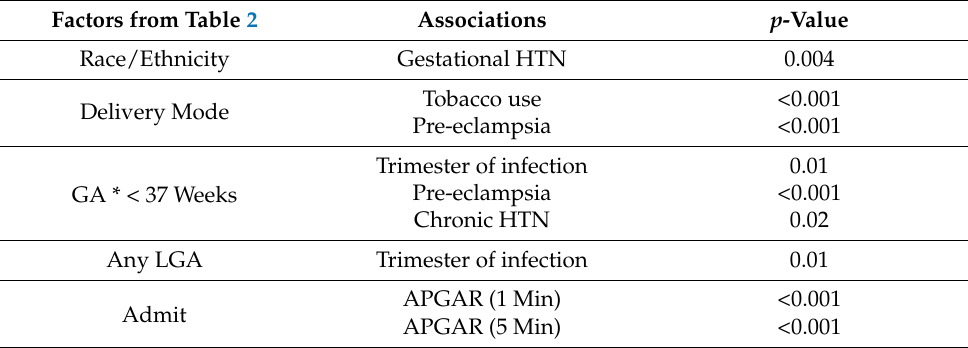
Table 5. Association between selected factors and other maternal and infant